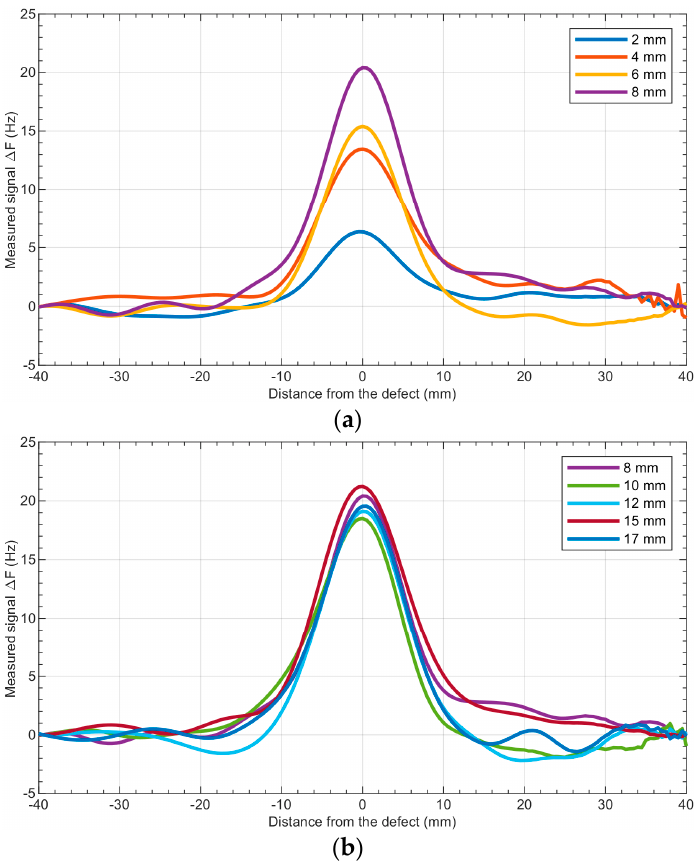
Figure 9. Results of the measurements for the aluminum sample—comparison of the measured signal (the deviation of the fundamental frequency ∆ f fund. ) for different depths of defects: ( a )—2–8 mm, ( b )—8–17 mm.